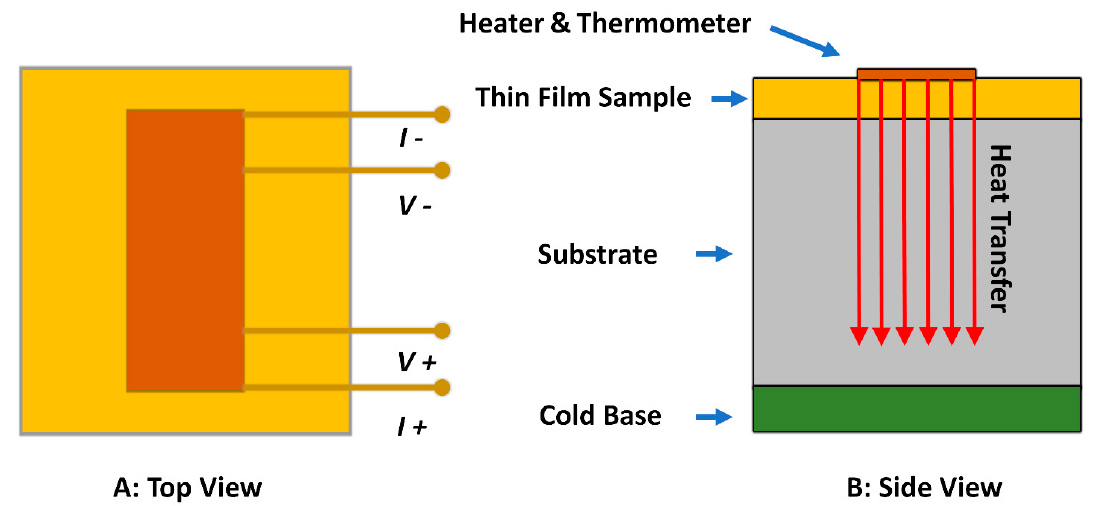
Figure 8. Experimental setup of the 3- ω method. A is the top view of the measurement setup, and B is the side view of the setup.